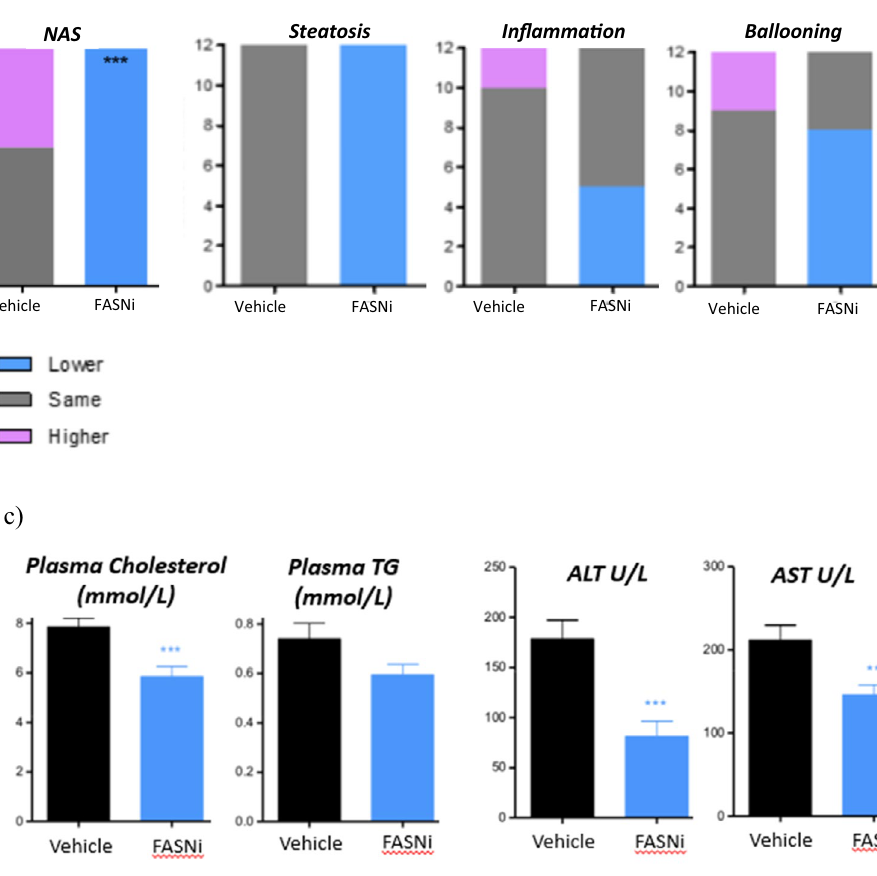
Figure 3. FASN inhibition reduces liver fat, metabolic parameters and NASH histology severity scores in a NASH diet induced therapeutic mouse model. ( a ) Effect of FASNi on liver histology. Left: Representative images of H&E stained liver sections at the end of the treatment period with vehicle or TVB-3664 (10 mg/ kg). Magnification 10x, scale bar = 200 µm. Right: Liver fat (steatosis) determined by histological scoring. Mean ± SEM (n = 11/12 per group). ***p < 0.001 vs vehicle, One-Way ANOVA with Dunnett’s multiple comparison test. ( b ) Effect of FASNi on liver NAS score. Histological scoring of liver at the end of the treatment period. The number of animals with a higher (worse, pink), no change (grey) or lower (improved, blue) histology score in liver samples at end of study compared to prestudy biopsies for each animal is indicated by the height of the bar. ***p < 0.001 vs vehicle, Fisher’s exact test followed by adjustment for multiple correction using the Bonferroni method. ( c ) Effect of FASNi on plasma ALT, AST, cholesterol and triglyerides at the end of the treatment period. Mean ± SEM. **p < 0.01, ***p < 0.001 vs vehicle, One-Way ANOVA with Dunnet’s multiple comparison